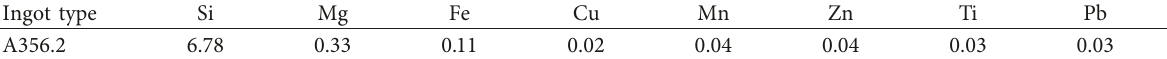
Table 1: Chemical composition (wt.%) of as-received A356.2 ingot. Ingot